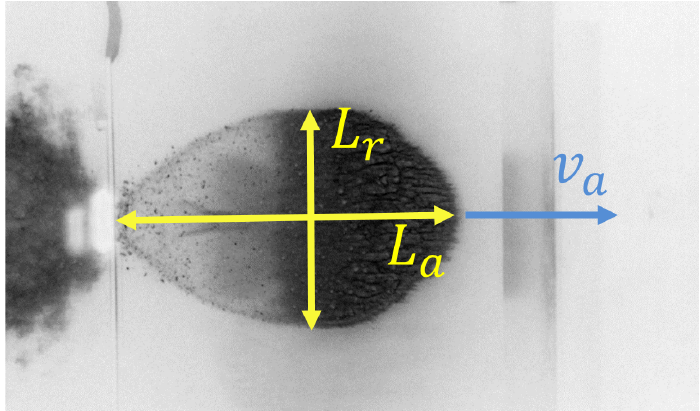
Figure 6. Experimental high-speed photograph of the debris cloud showing the cloud’s length ratio R = L a / L r , and axial expansion velocity, v a . The witness plate seen in the right side of the snapshot is shown in Figure 8. The image intensity has been inverted for better viewing. Figure courtesy of Fraunhofer